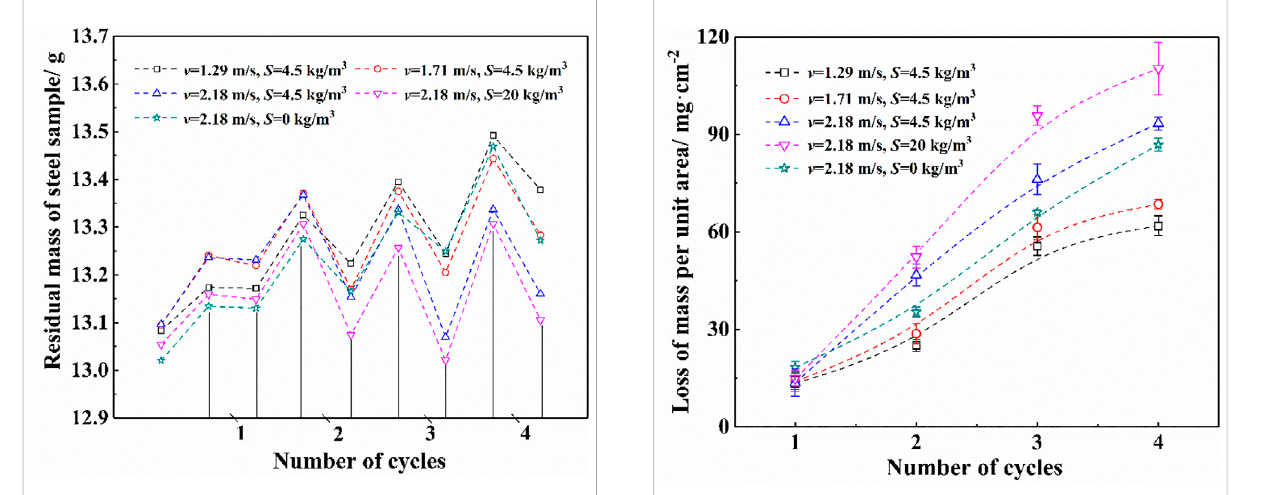
FIGURE 6 Loss of mass per unit area for the steel samples versus the number of